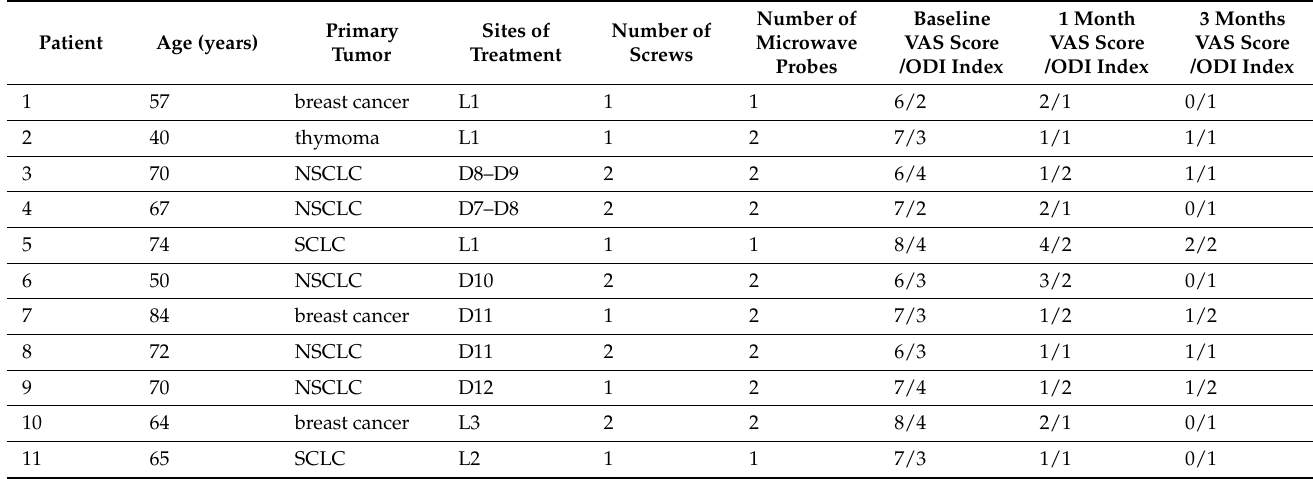
Table 1. Histology of primary malignancies, topographic distribution of tumor lesions, devices used and clinical evaluation of the study